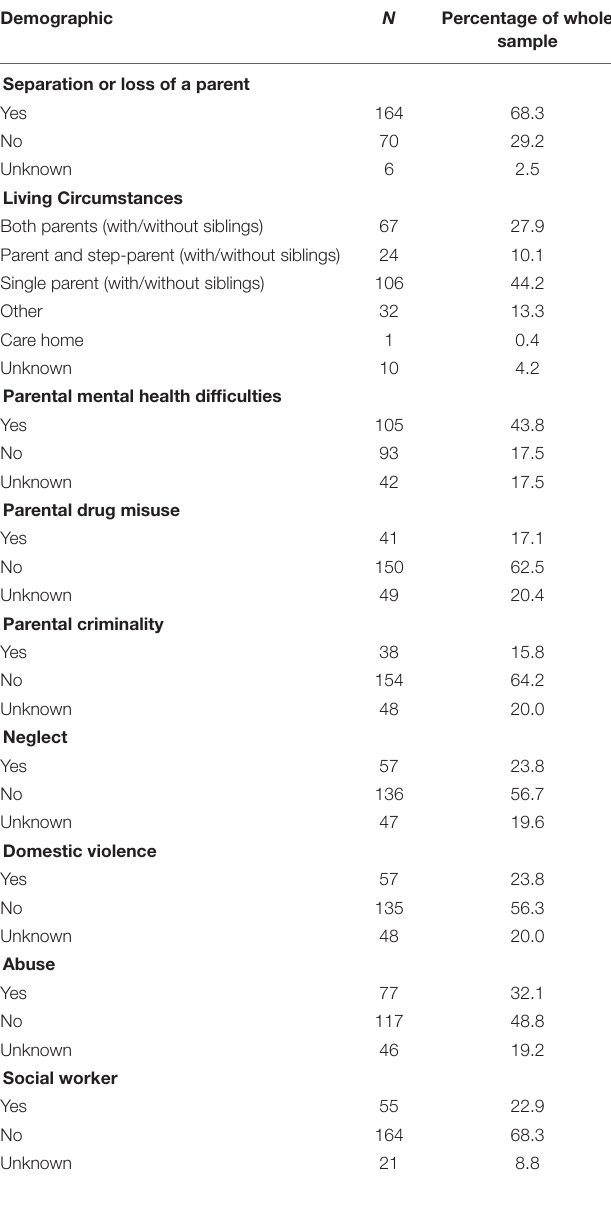
TABLE 2 | Familial socio-demographic characteristics of patients presenting in suicidal crisis.